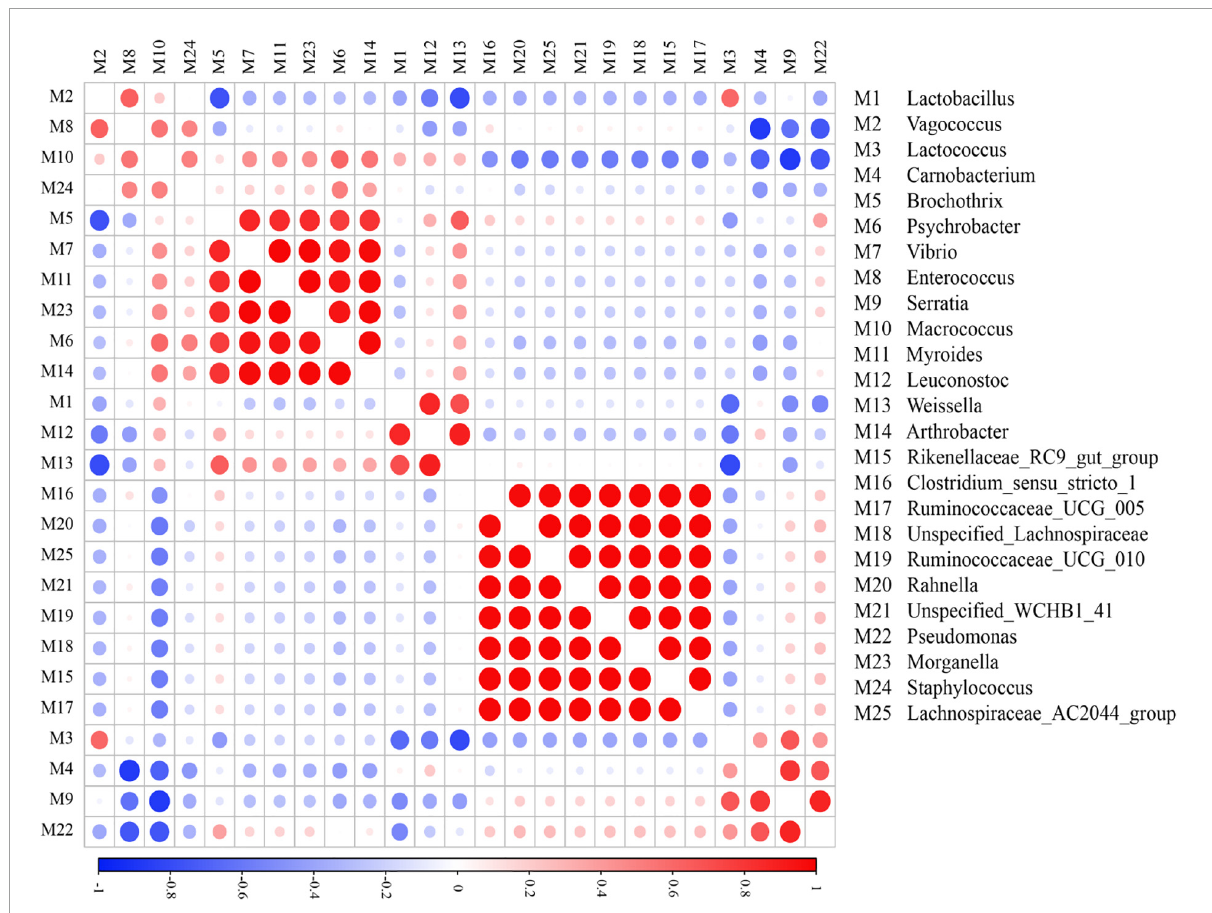
FIGURE4 Co-occurrence and exclusion correlations among bacteria at the genus level. Strong correlations are shown by large circles, while weak correlations are shown by small